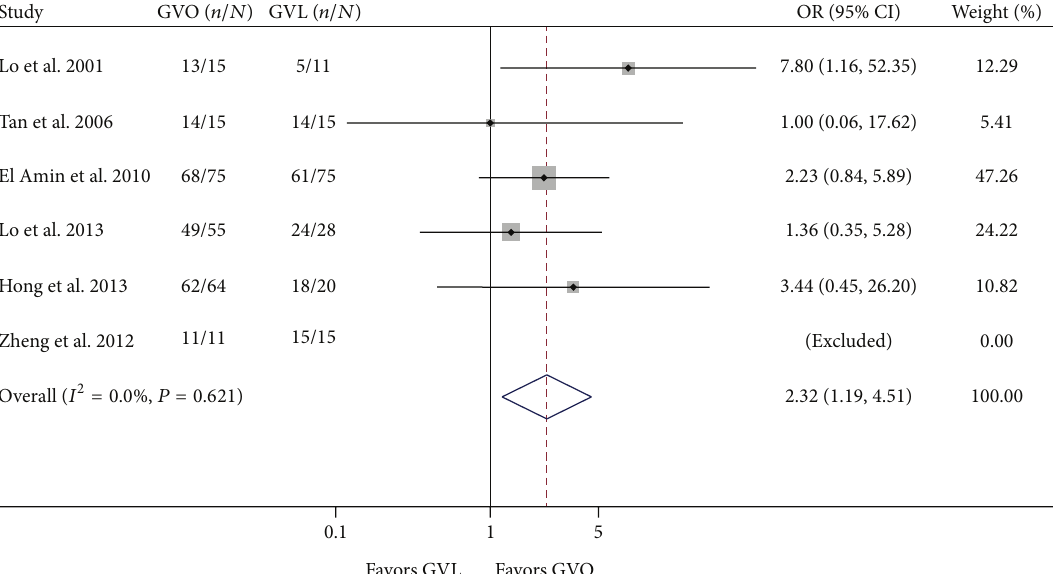
Figure 3: Comparison of hemostasis of active bleeding in the GVO and GVL groups. GVO, cyanoacrylate injection; GVL, band ligation; CI, confidence interval; OR, odds